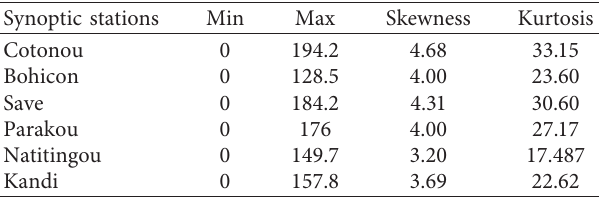
Table 1: Statistical description of the whole sixty-year daily me- teorological time series from Benin’s synoptic stations. . Synoptic stations Min Max Skewness Cotonou